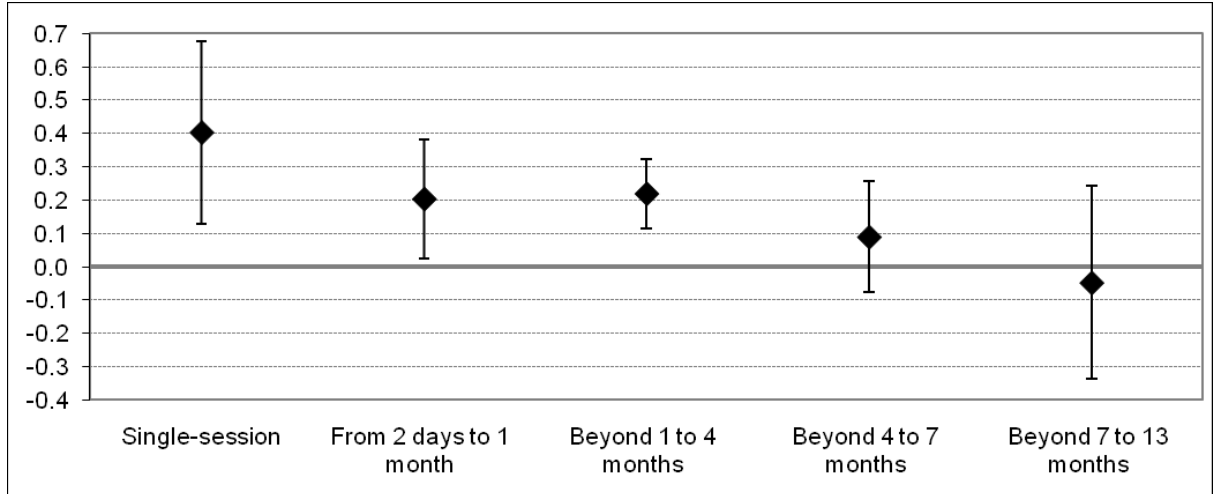
Figure 4. Effect Size by intervention